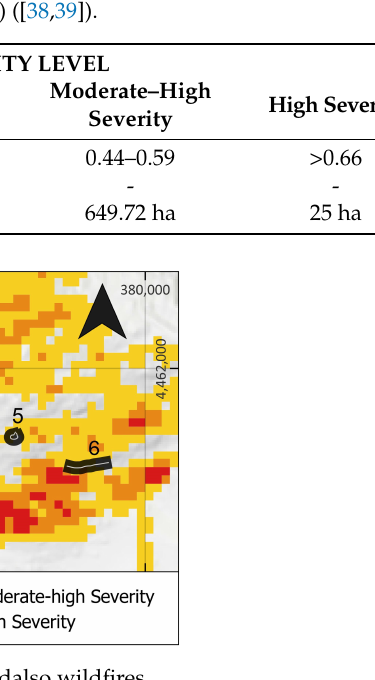
Figure 6. Maps of the dNBR of the ( a ) Oliana and ( b ) Cadalso